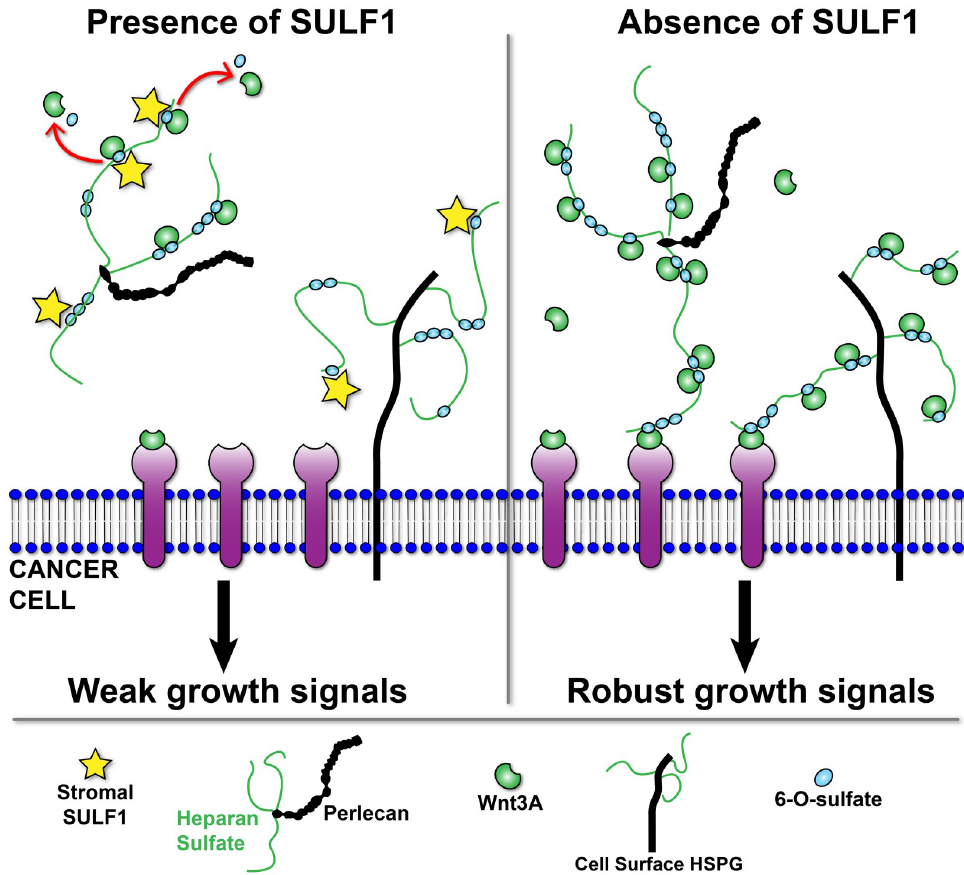
Fig 6. Model for SULF1 tumor-suppressing role in PCa biomimetic hydrogels. Stroma-derived SULF1 (yellow stars) promote 6-O-desulfation of heparan sulfate (HS) chains (thin green lines) on HSPGs in the matrix, such as perlecan, and at cell surface. This action results in reduced signaling due to 1) releasing of HBGFs from HSPGs, and 2) disturbing formation of ternary signaling complexes. Lack of SULF1 in the microenvironment allows HBGFs to remain stabilized on HSPGs and to activate receptors at the cell surface, promoting